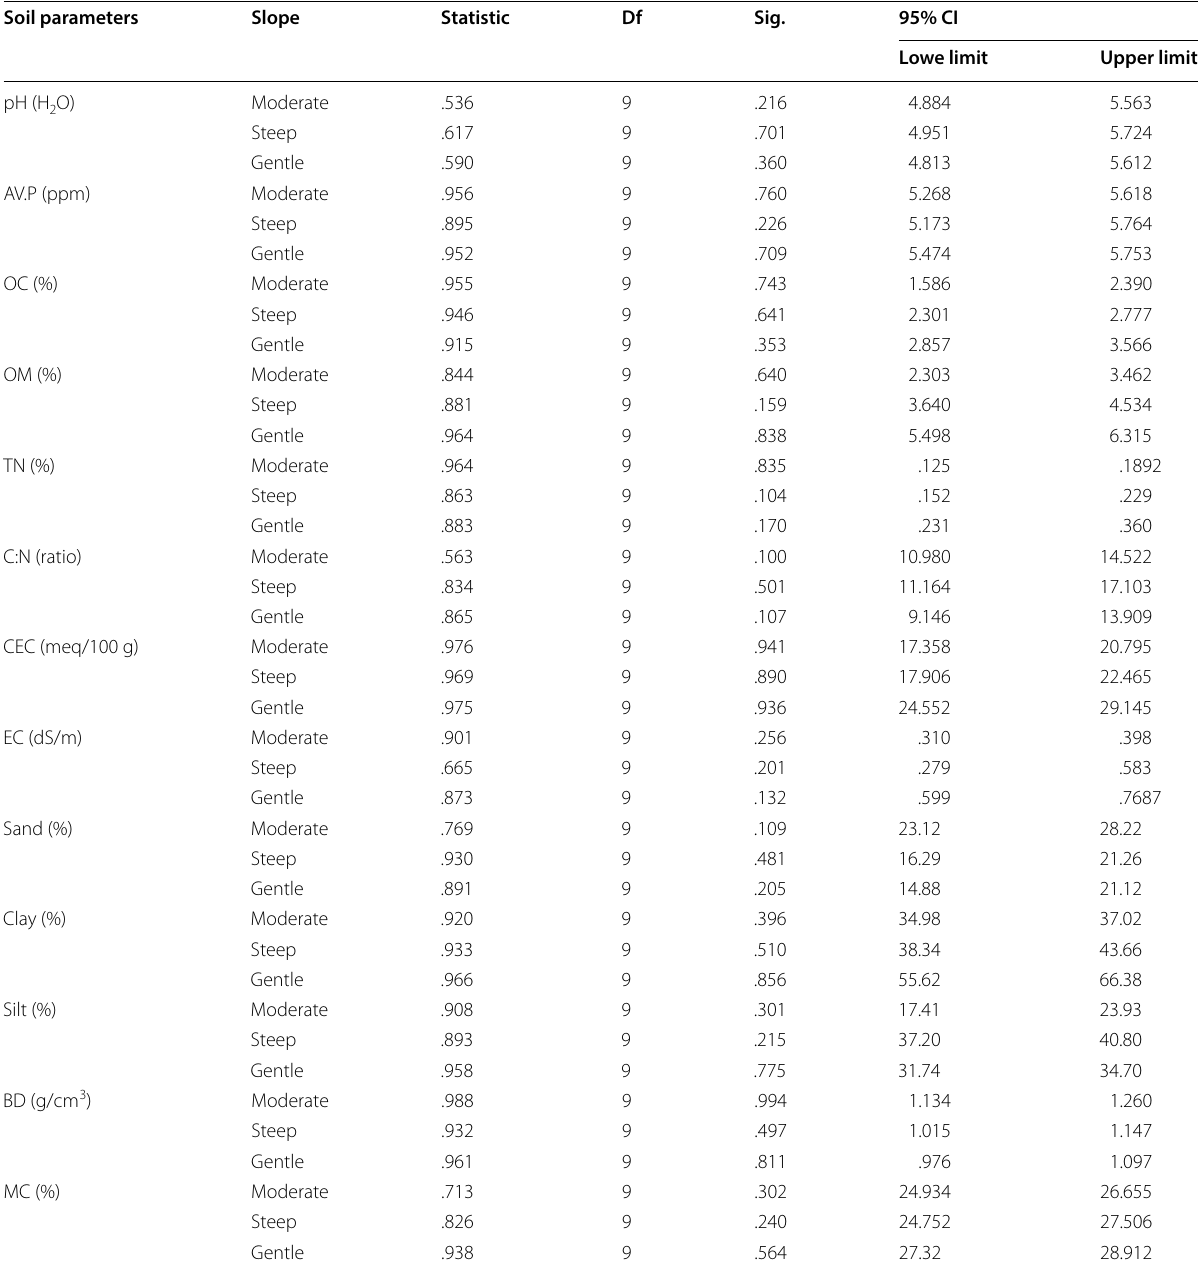
Table 3 Soil sample distribution and confidence interval (CI) test Soil parameters Slope Statistic